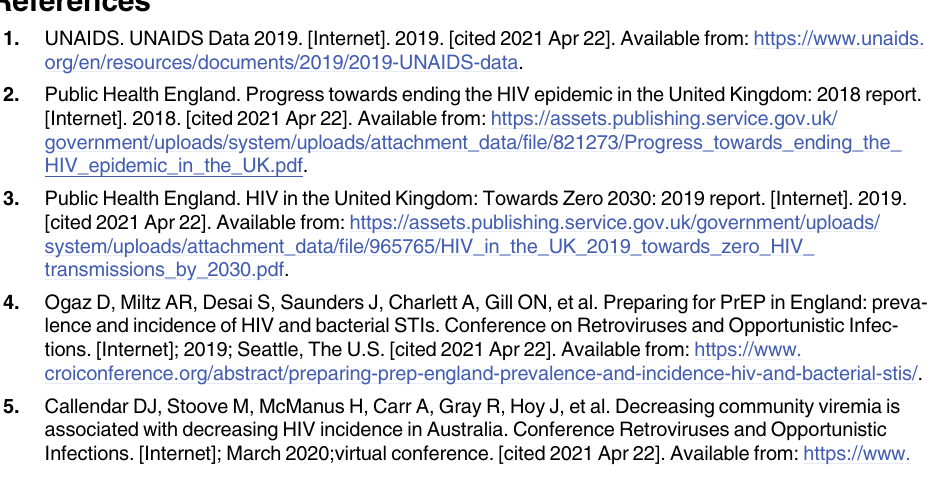
S3 Table. Associations between ethnicity, education, and employment characteristics with sexual behaviour measures at baseline among 1,162 GBMSM in the AURAH2